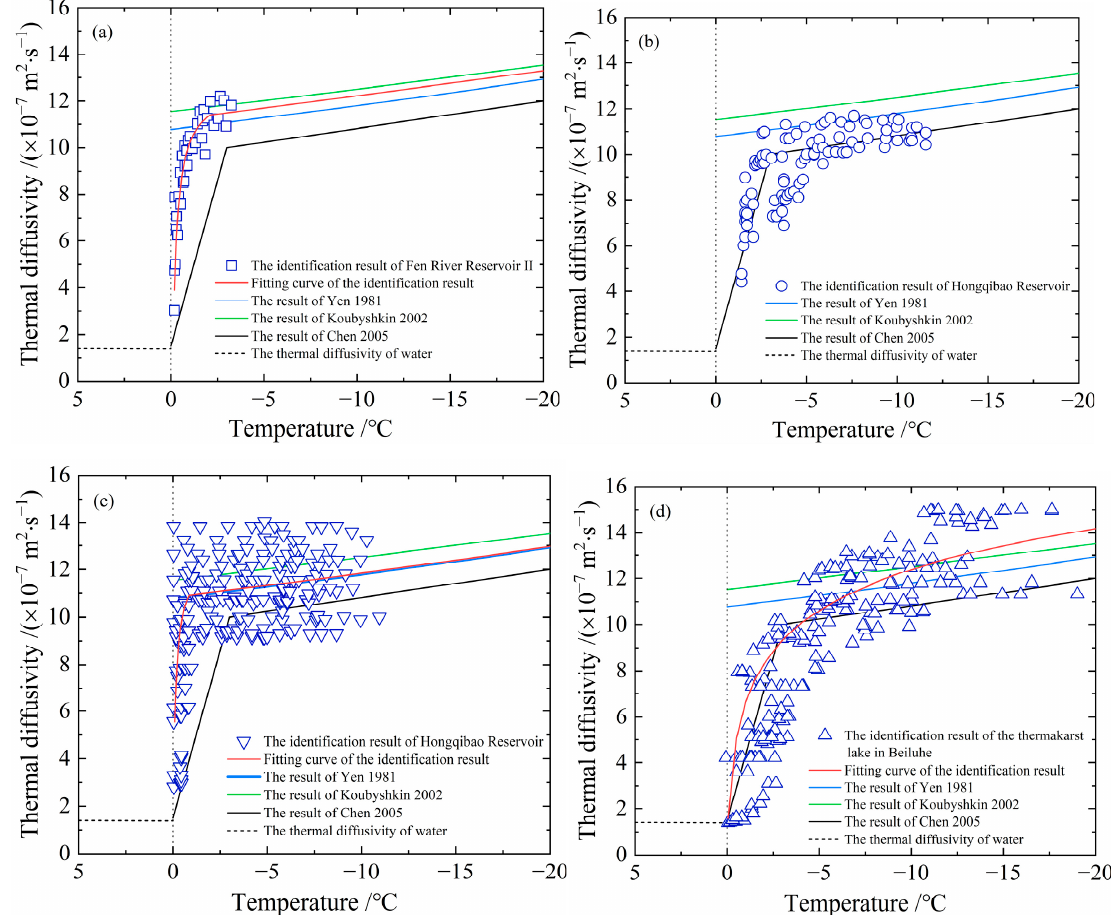
Figure 5. Relationship between inversion-identified thermal diffusivity of different freshwater ice survey data in China and temperature: ( a ) Fen River Reservoir II (modified from Ref. [38]), ( b ) Hongqibao Reservoir (modified from Ref. [46]), ( c ) Hongqibao Reservoir (modified from Ref. [48]), and ( d ) Beiluhe on the Qinghai-Tibet Plateau (modified from Ref. [27]). Some data used in the ( a – d ) are from Refs. [29–31].